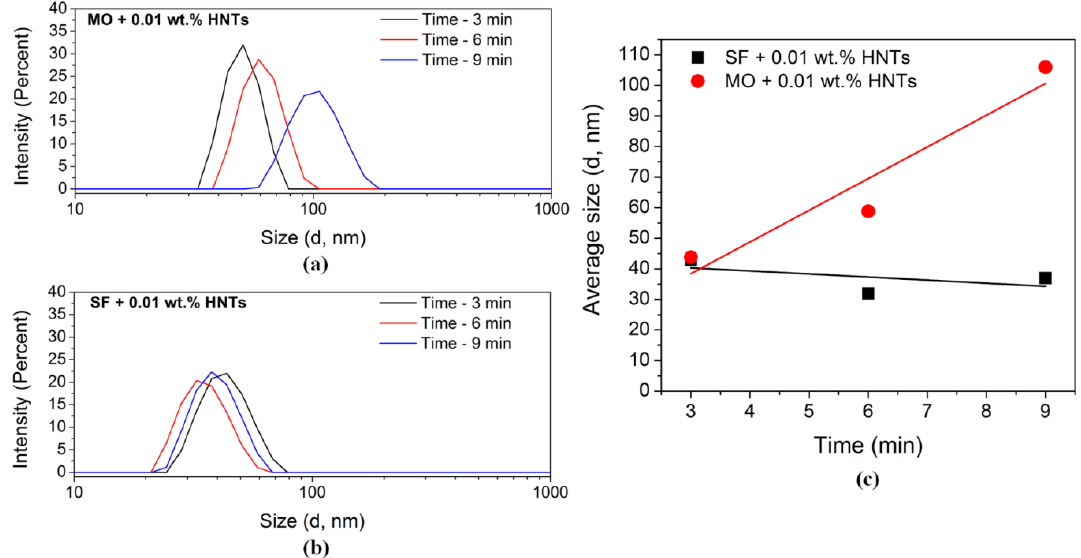
Figure 2. ( a ) Hydrodynamic size distribution of HNTs over time for MO + 0.01 wt. % HNT; ( b ) Hydrodynamic size distribution of HNTs over time for SF + 0.01 wt. % HNTs; ( c ) Average HNTs hydrodynamic diameter over time comparison for MO + 0.01 wt. % HNTs and SF + 0.01 wt. % HNTs. Lower stability is found for MO nanofluids.